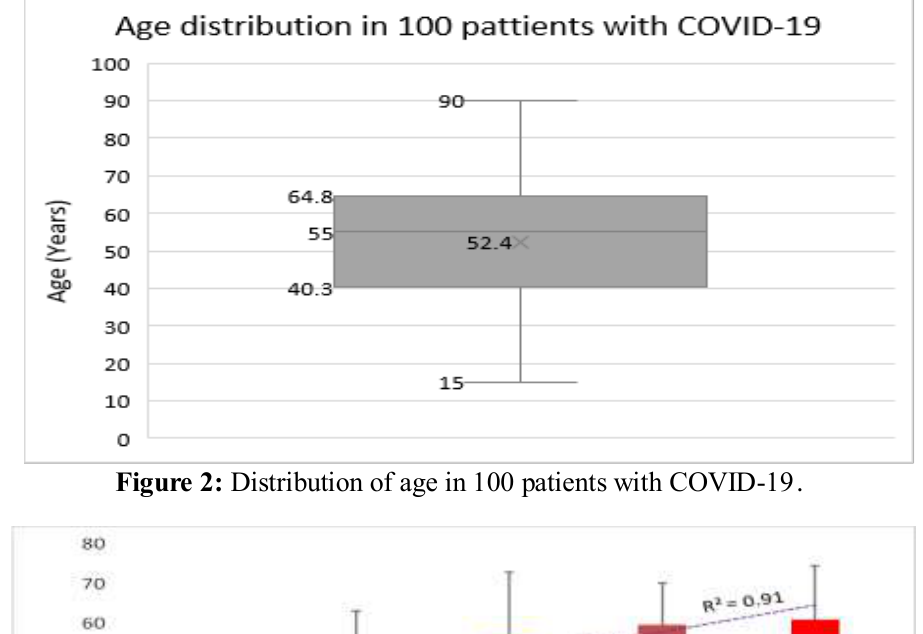
Figure 2: Distribution of age in 100 patients with COVID-19 .